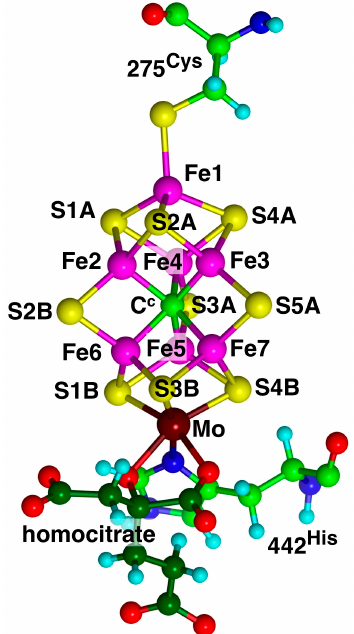
Figure 1. The structure and ligation of FeMo-co. Atom labels are those of the Azotobacter vinelandii protein, crystal structure PDB 3U7Q.